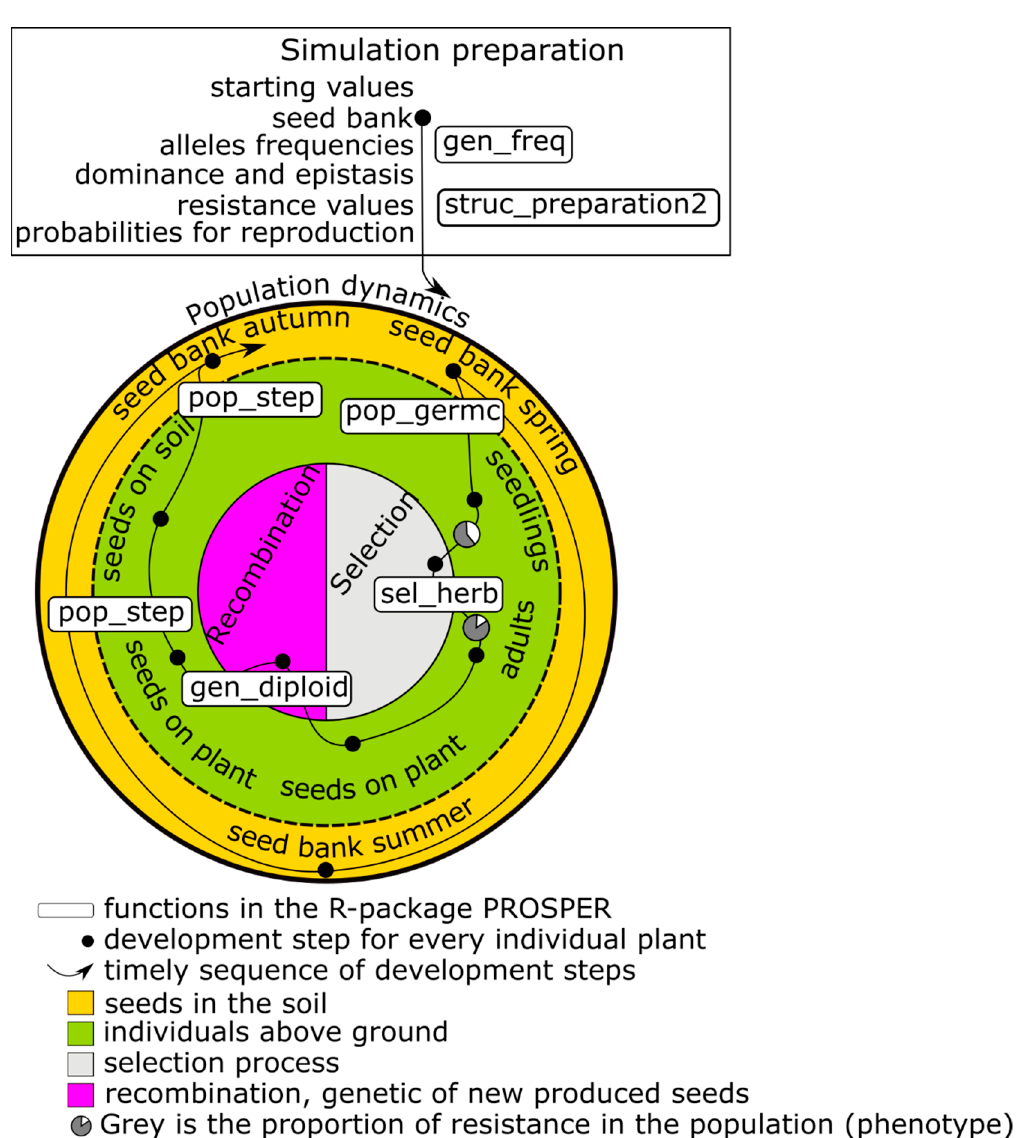
Figure 1. The structure of PROSPER simulation models with the two blocks “simulation preparation” and the reproduction cycle of “population dynamics”. Only selected functions are displayed.